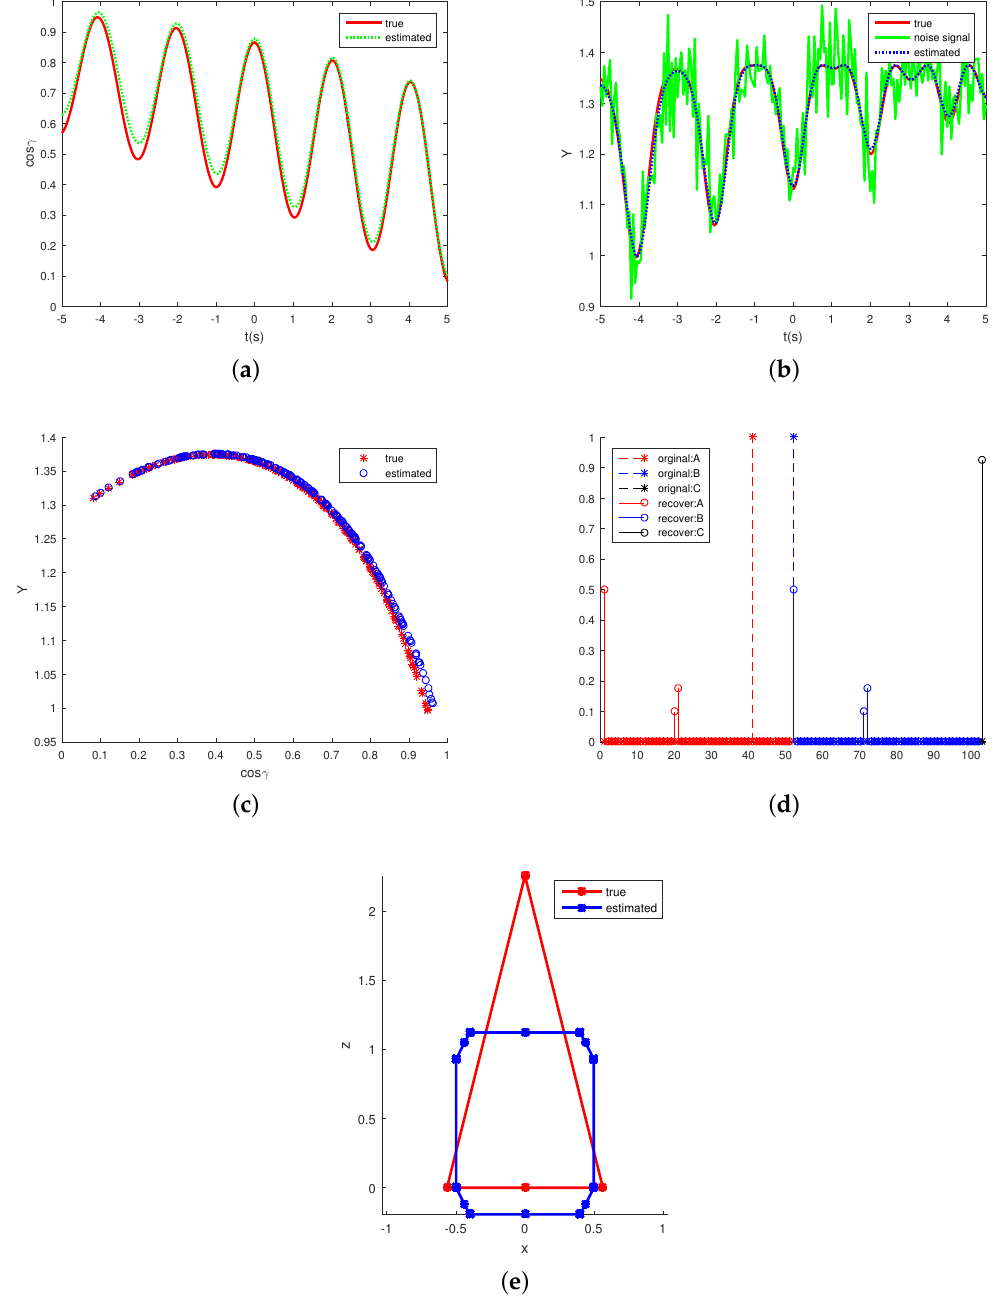
Figure 6. Estimation of the projecting functions. ( a ) shows the estimation of observing angles; ( b ) shows the estimating of the emissivity-area products; ( c ) plots the true and estimated cosine observing angle-emissivity-area product pairs, which also represent the projection functions; ( d ) illustrates the true and estimated projecting function representation, A denotes the coefficients of top cone base functions, B denotes coefficients of the bottom cone base function and C denotes the medium cylinder base function coefficient; and ( e ) shows the side view of the true and estimated